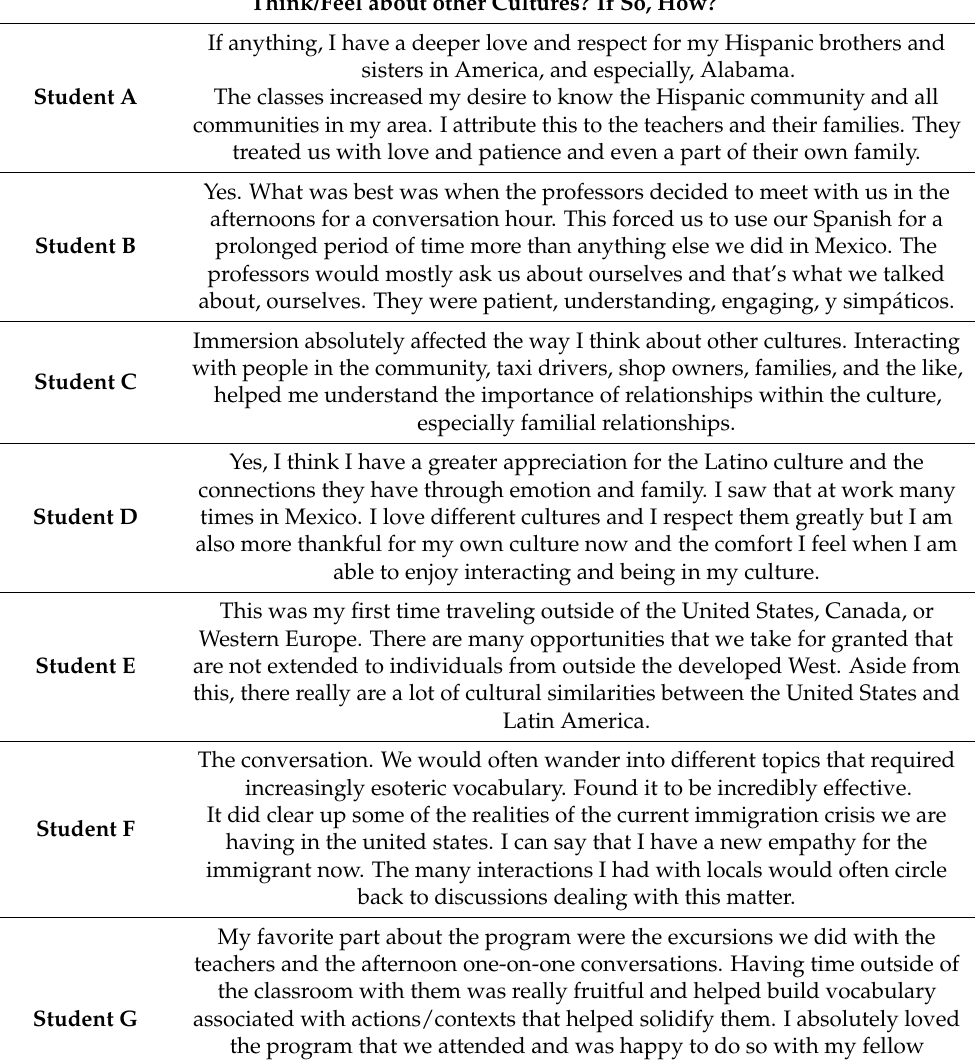
Table 5. Question